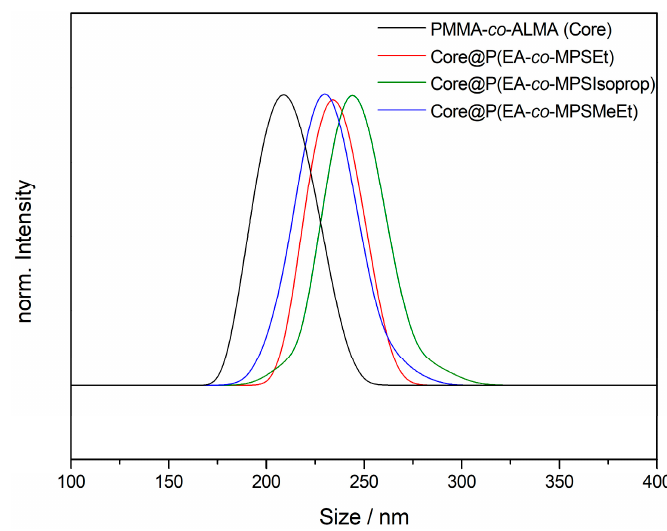
Figure 2. TEM Images of the P(MMA- co -ALMA) core particles ( a , b ) and the corresponding P(MMA- co -ALMA)@P(EA- co -MPSEt) core–shell particles ( c , d ). Scale bars correspond to 1000 nm ( left ) and 250 nm ( right ), respectively.